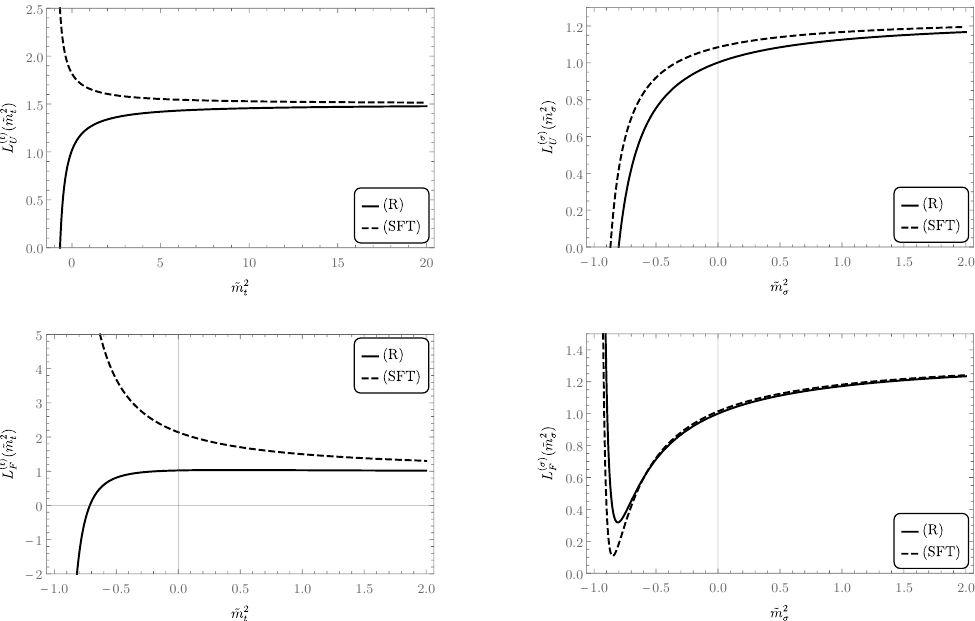
( ˜ m 2 ) and L ( σ ) ( ˜ m 2 ) as functions of the dimensionless masses ˜ m 2 t σ i i